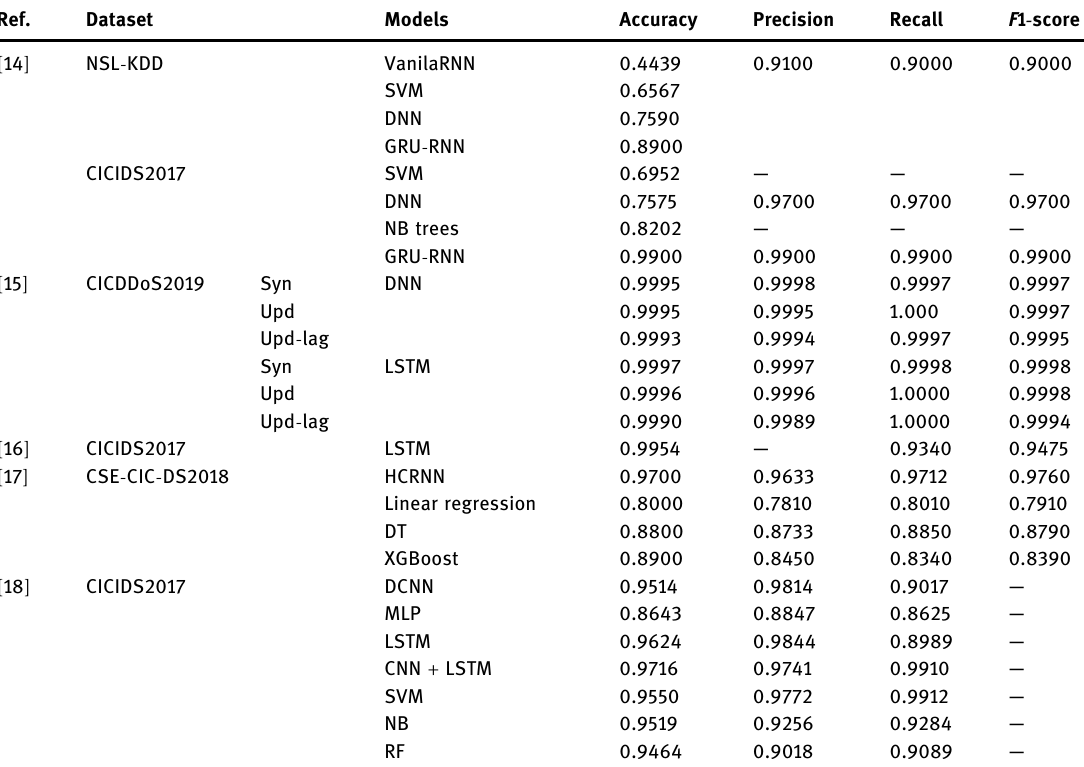
Table 2: The related work results that used either the same dataset or the same deep learning models Ref.